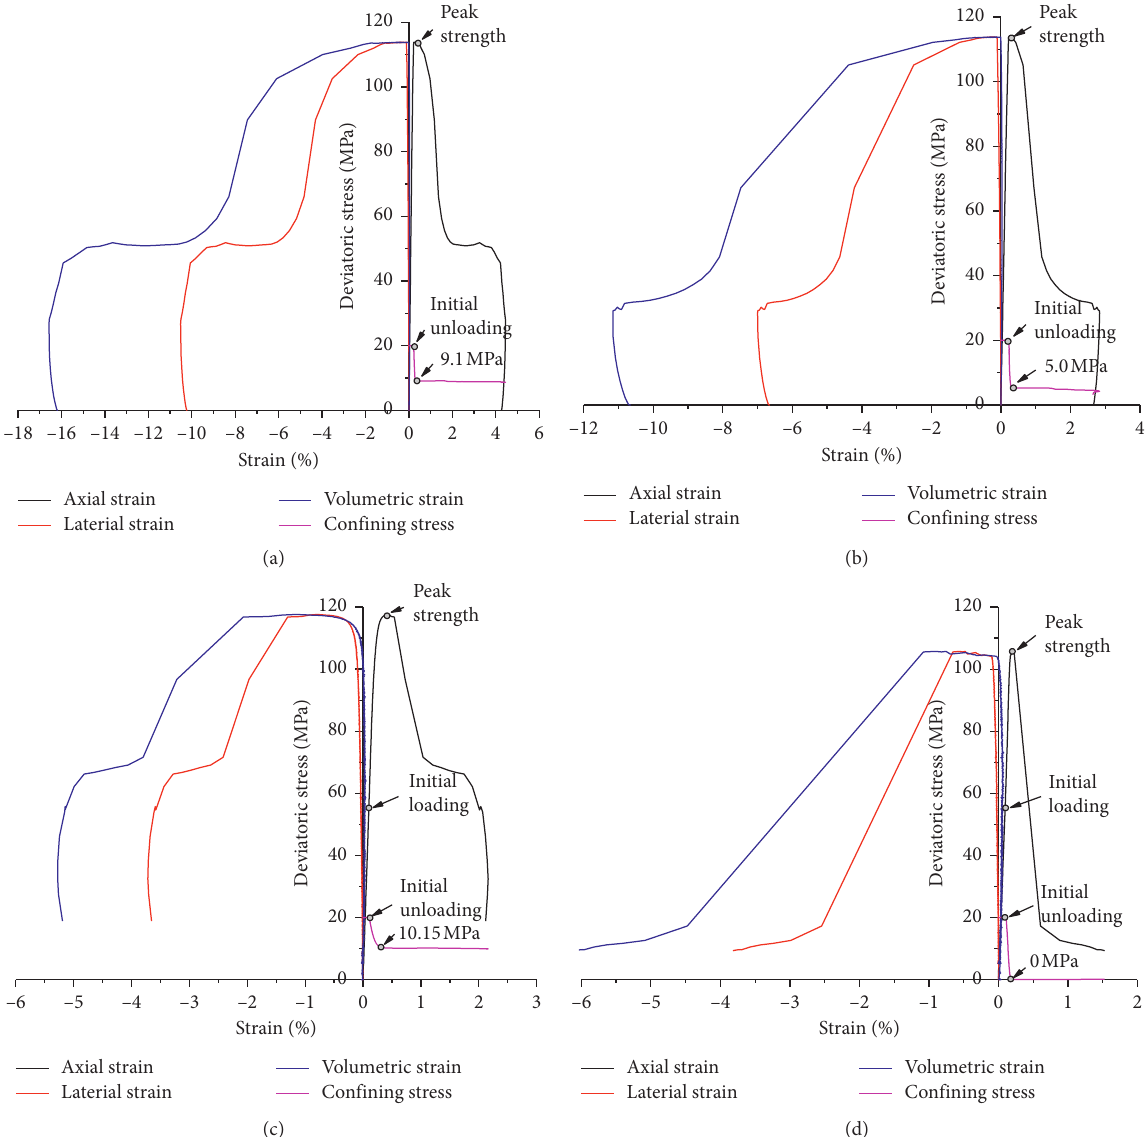
Figure 5: Stress-strain curves in complex loading-unloading stress tests (confining pressure: 20MPa): (a) sample 14; (b) sample 15; (c) sample 16; and (d) sample